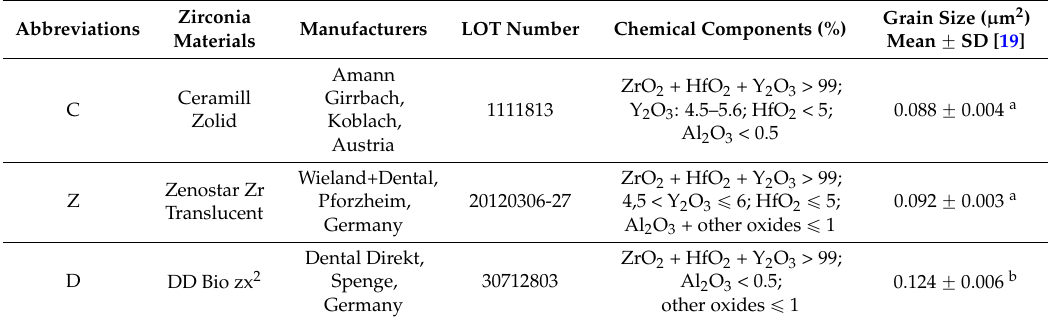
Table 1. Summary of materials used in the present study, their manufacturer with LOT number, chemical components, and grain